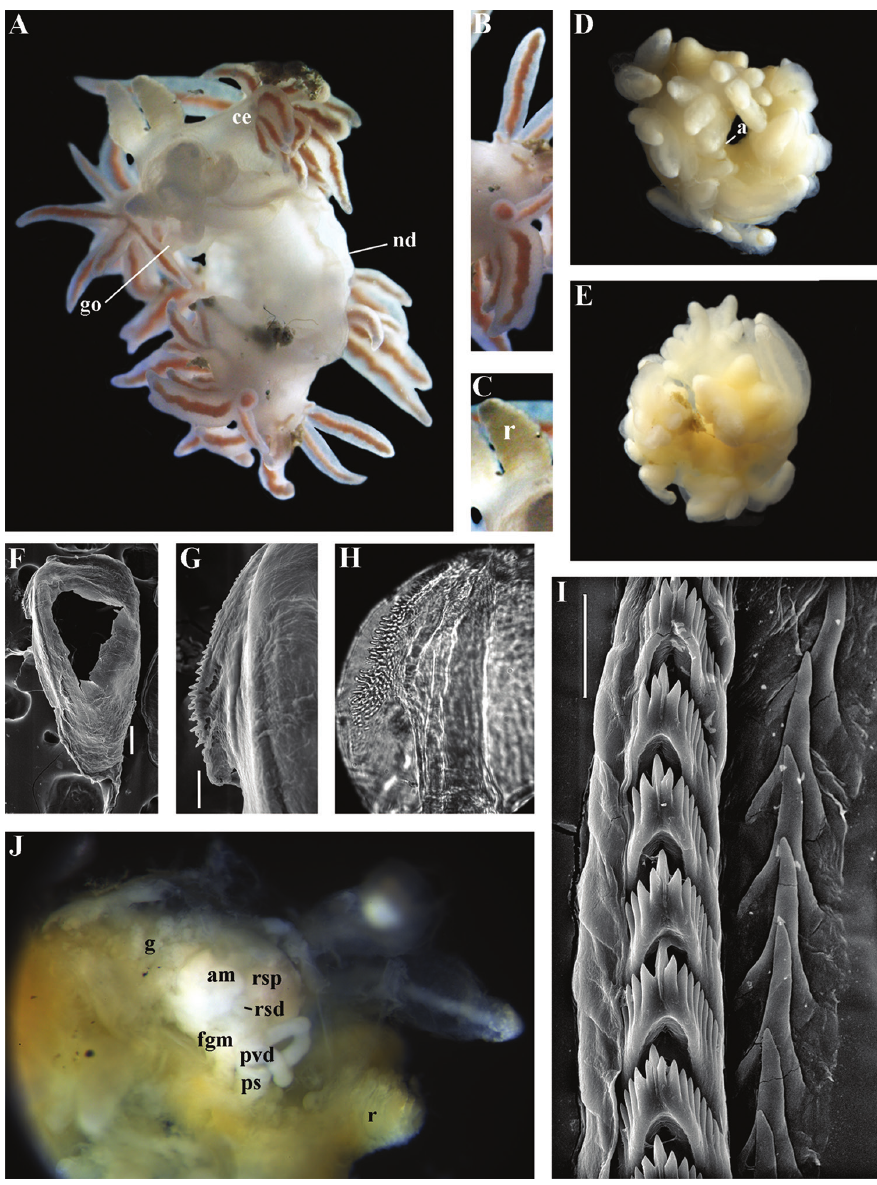
Figure 35. Carronella enne sp. n. NE Atlantic, off Ireland. ZMMU Op-526, specimen 5 mm (fixed) in length: A dorsal view (live); B details of cerata C rhinophore D dorsal view (fixed) E ventro-lateral (fixed) F jaw, SEM G details of masticatory process of jaw, SEM H details of masticatory process of jaw, light microscopy I radular teeth, posterior part, SEM J reproductive system, light microscopy. Abbreviations: a anus am ampulla ce ceratal elevations fgm female gland mass g gonad go genital opening nd dis- continuous notal edge ps penial sheath pvd prostatic vas deferens r rhinophores rsd distal receptaculum seminis rsp proximal receptaculum seminis. Scale bars: F = 300 μm; G, I = 30 μm. Photos of living specimens by E. Schwabe, other photos and SEM images by A.V.